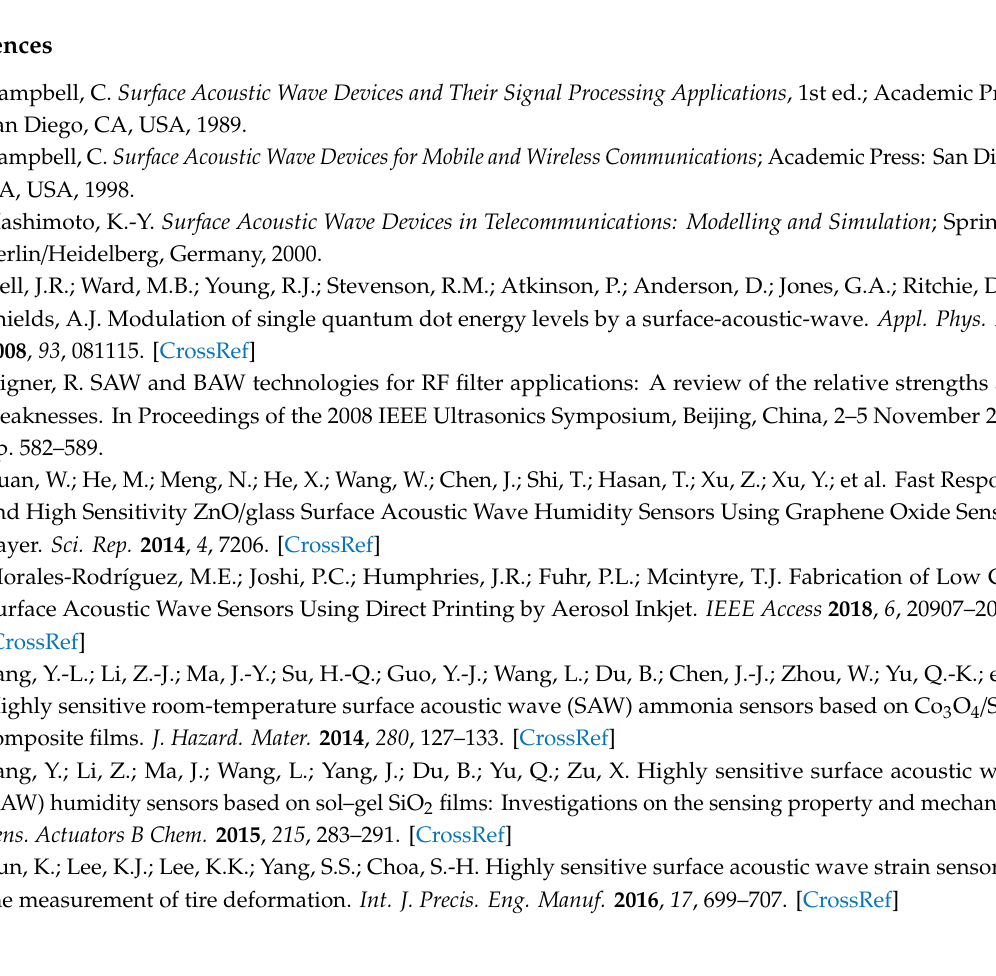
Figure S1: Manufacturing process of SAW devices in LAUM’s clean room, Figure S2: Photos of the SAW sensor and further details of the interdigital transducers (IDTs), Figure S3: Details of the printed circuit board (PCB), Figure S4: Details of the fluidic